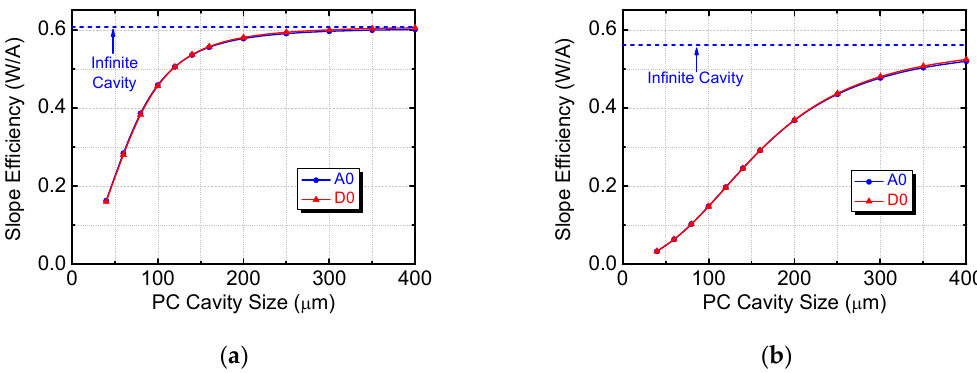
Figure 10. Finite cavity with CC design ( f 1 , f 2 , ∆ ) = (0.15, 0.05, a /3): the slope efficiency of the two lowest fundamental modes as a function of PC cavity size for ( a ) air-hole and ( b ) air-pillar PC-SELs.